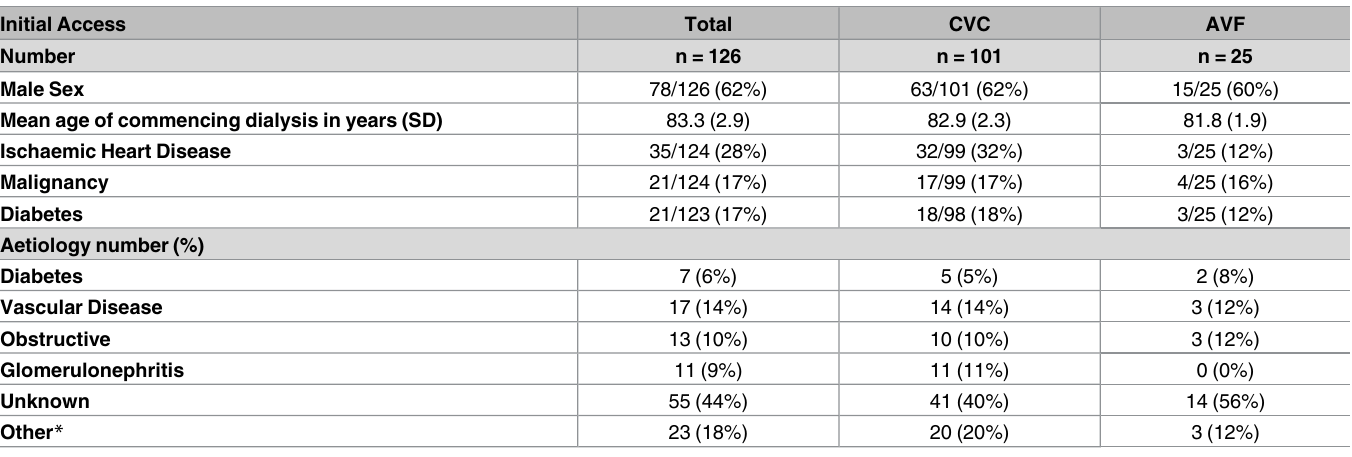
Table 1. Patient Baseline